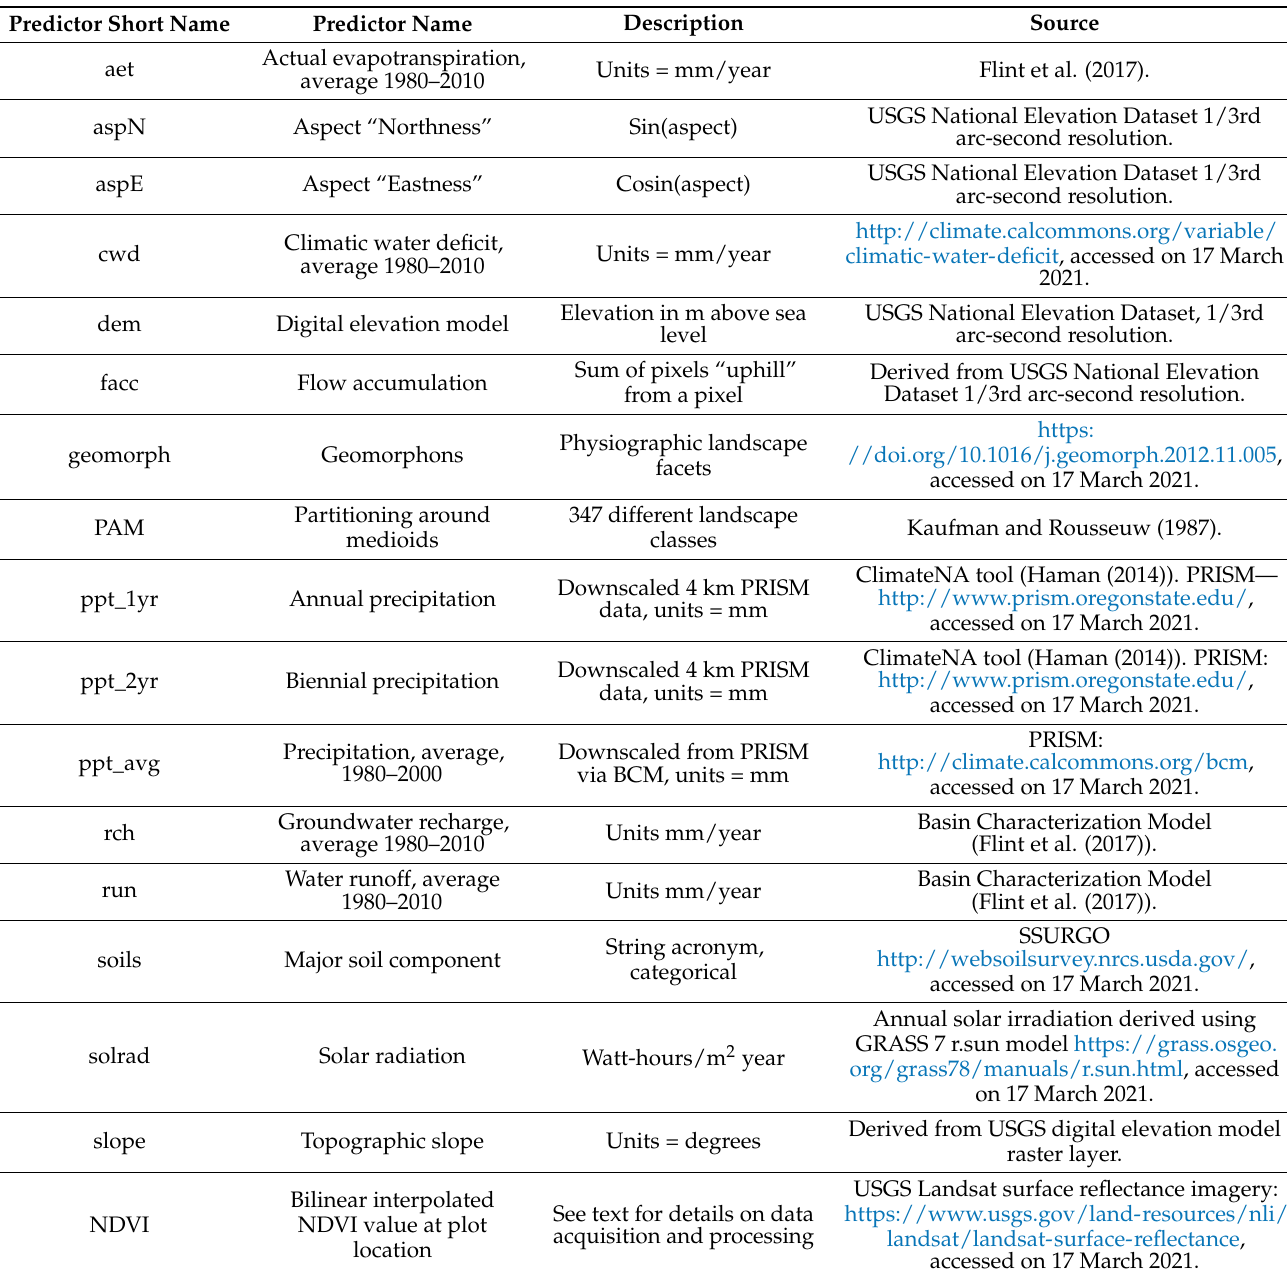
Table 1. Description of the predictor variables extracted from GIS raster layers. PRISM is the Parameter–Elevation Regressions on Independent Slopes Model [45] and BCM is the Basin Characterization Model [40]. NDVI is the Normalized Differential Vegetation Index, and SSURGO is the Soil Survey (https://websoilsurvey.sc.egov.usda.gov/, accessed on 23 October